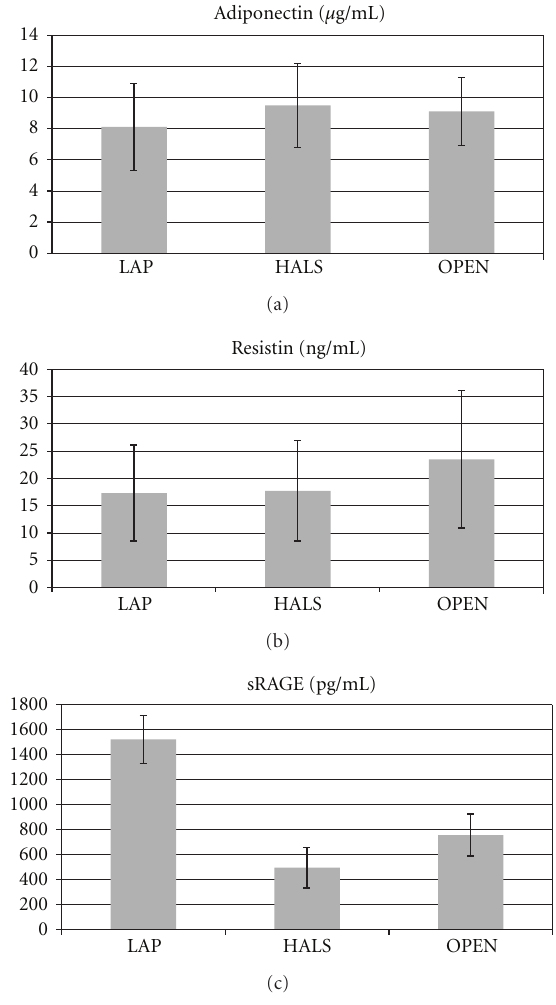
Figure 3: Mean values of serum adiponectin, resistin, and sRAGE. LAP, laparoscopy; HALS, hand-assisted laparoscopy; OPEN, open